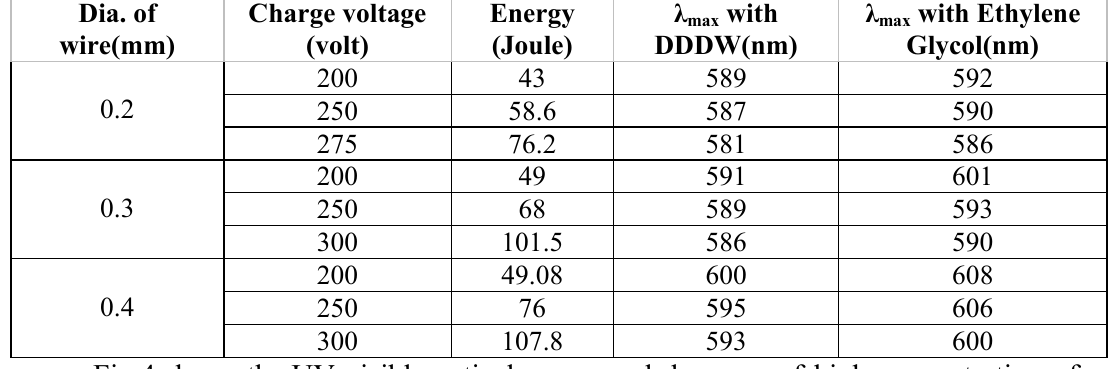
Table 2: Plasmon absorption peaks at different diameters of wire and charging voltage for copper nanoparticles in three media.